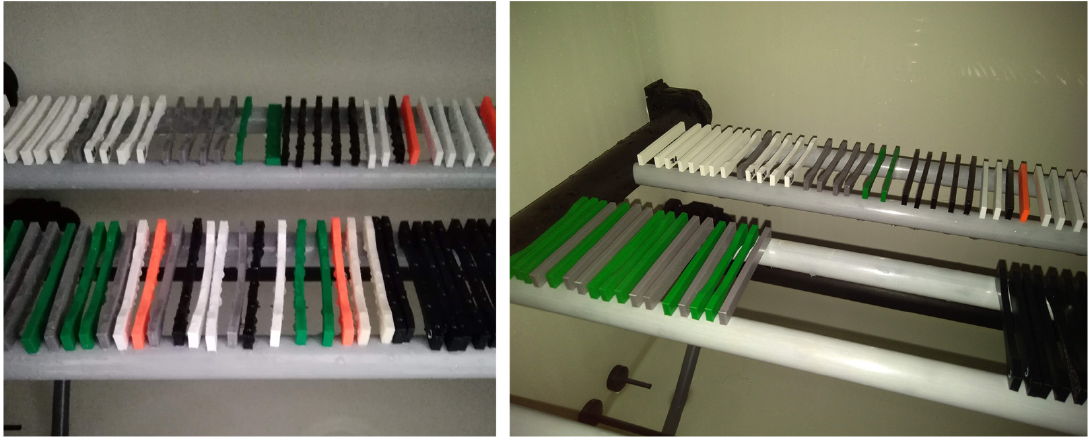
Figure 4. Set of test samples for placement in the condensation chamber.